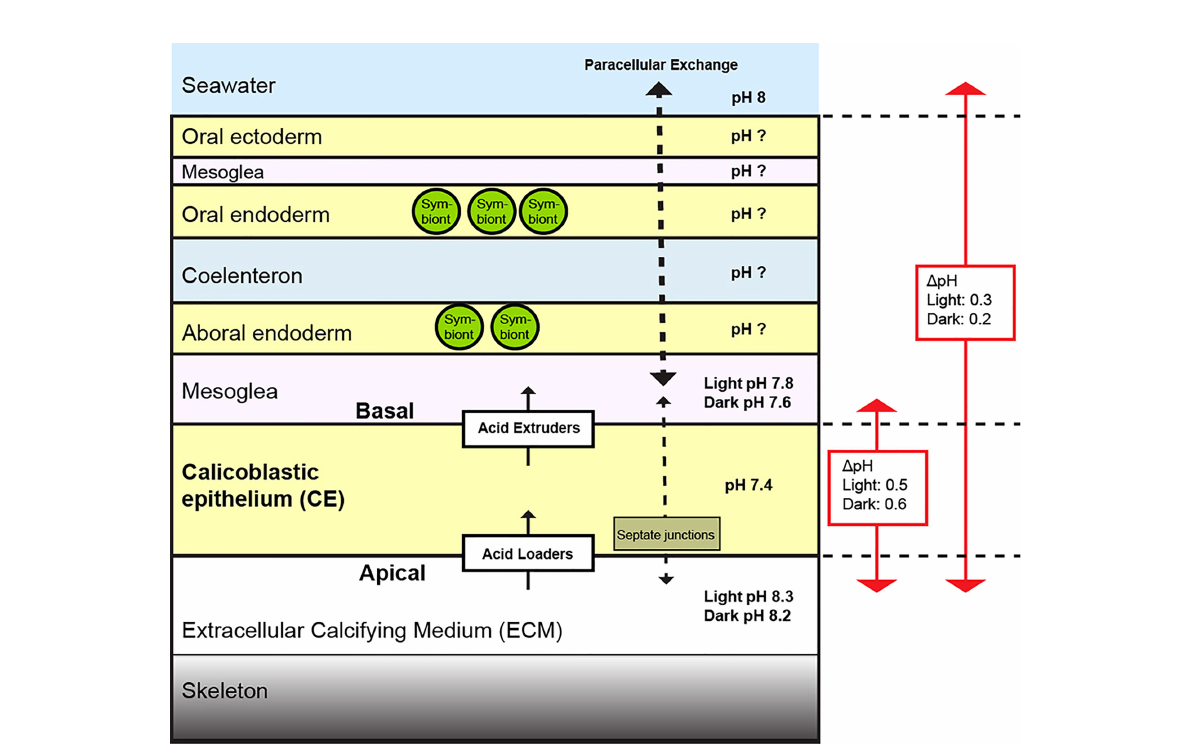
FIGURE 4 Diagram depicting proposed factors involved in pH regulation of the ECM by the calicoblastic epithelium (CE) at the growing edge of S. pistillata in seawater pH 8. Regulation of pH on the apical side of the CE occurs via net acid loaders. On the basal membrane of the CE there are acid extruders that decrease pH in the mesoglea. Paracellular permeability is greater between seawater and the mesoglea (thicker dashed arrow) than between the mesoglea and the ECM due to properties of septate junctions in the CE (thinner dashed arrow) (Tambutte ́ et al., 2011). The pH gradient between the ECM and mesoglea is different to that between the ECM and seawater. The pH gradients between the ECM and other tissue layers are currently not known and an important area of future